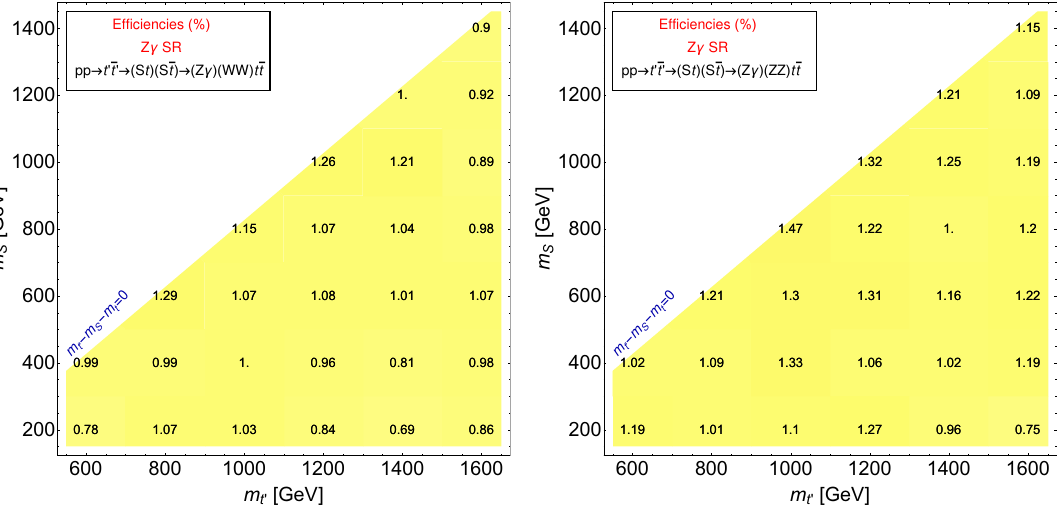
Figure 21 . E(cid:14)ciencies for the Z (cid:13) SR and for channels where at least one of the two S decays into Z (cid:13)